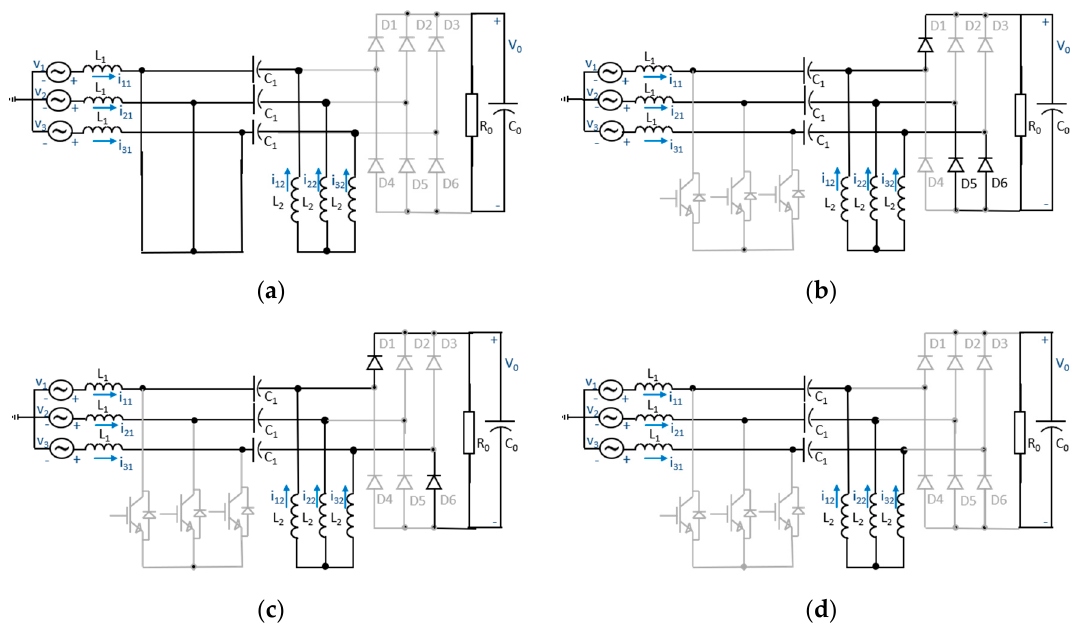
Figure 4. 3 ϕ SEPIC-type equivalent circuit during stages: ( a ) first stage (t on ); ( b ) second stage (t don1 ); ( c ) third stage (t don2 ); ( d ) fourth stage (freewheeling).